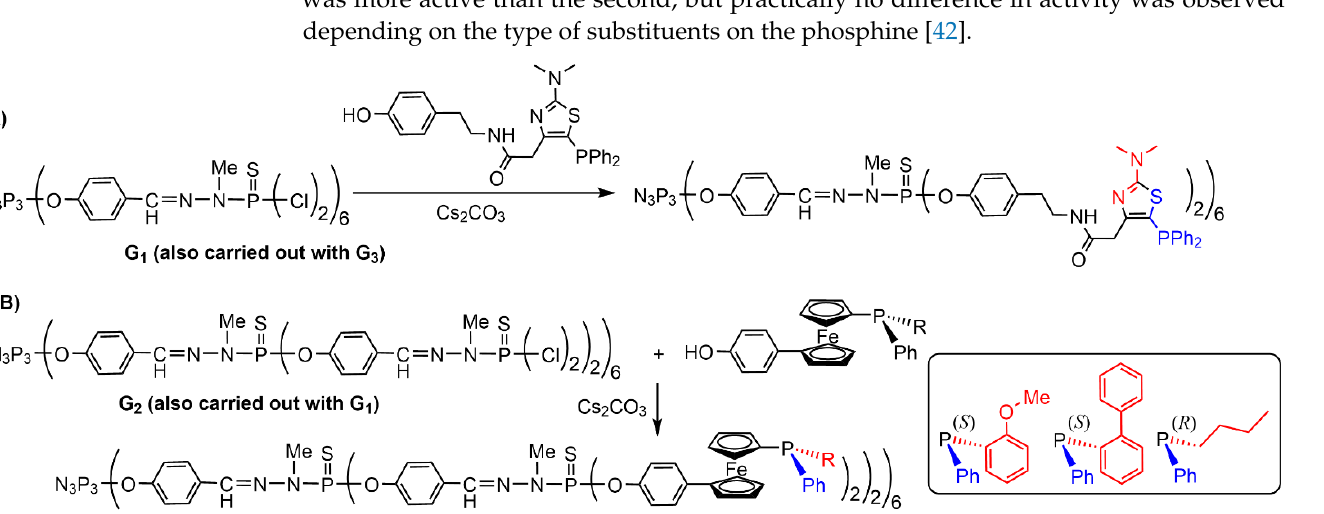
Figure 3. Allylic alkylation catalyzed by the Pd complex of the G 3 dendrimer shown in Scheme 3. Another example of bifunctional monophosphine concerns a thiazolyldiphe-